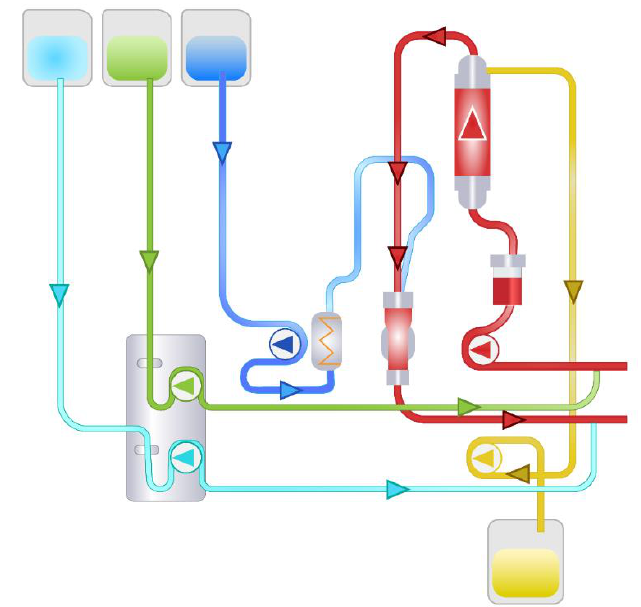
Figure 2. Semipermeable membrane-based plasmapheresis with citrate anticoagulation: light-blue—calcium line, green—citrate line, dark blue—replacement fluid line, yellow—effluent line, red—venous and arterial lines [10].